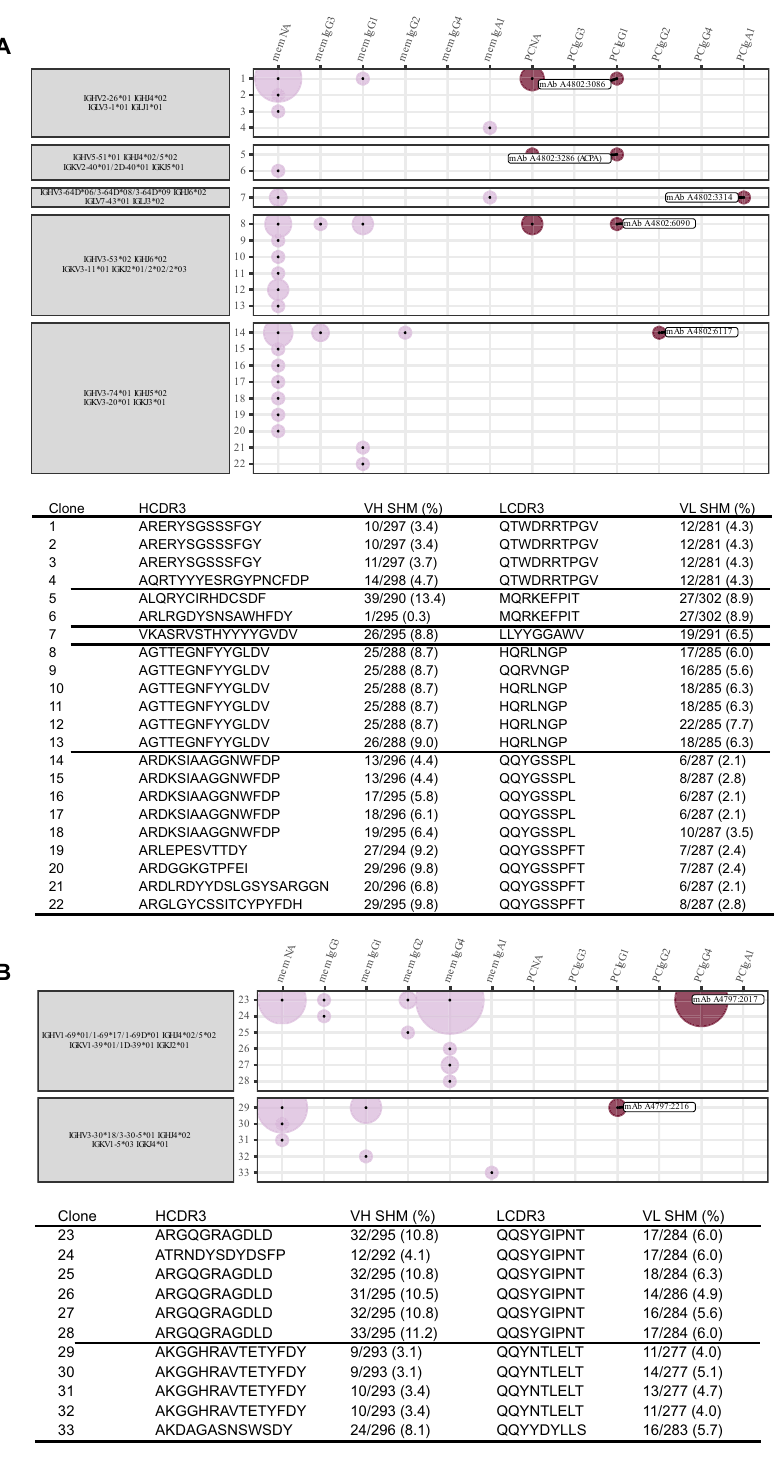
Figure 5. Clonotype characterization of synovial plasma cell derived antibodies. ( A ) We show clonotypes for five plasma cell derived monoclonal antibodies from A2. Each clonotype is defined by identical heavy and light chain V and J gene usage (grey boxes). Each clone with a unique sequence for the combination of heavy and light chain is assigned a number (y-axis). This sequence is described by the SHM and the complementary determining region 3 (CDR3) for the heavy and light chain in the table below. The x-axis and dot color depict the memory B (mem) or plasma cell (PC) cluster identity of the clone members by transcriptomic profile. It additionally defines the heavy chain isotype of the clone members in the order of possible class switch recombination from left to right. NA means not available from the data. The area of the dots is proportional to the number of identified members; e.g. the largest area within the first clone is equivalent to 16 members while the smallest area is equivalent to 1 member. ( B ) The plot shows the equivalent clonotype information that is shown in panel (A) for the two plasma cell derived monoclonal antibodies from